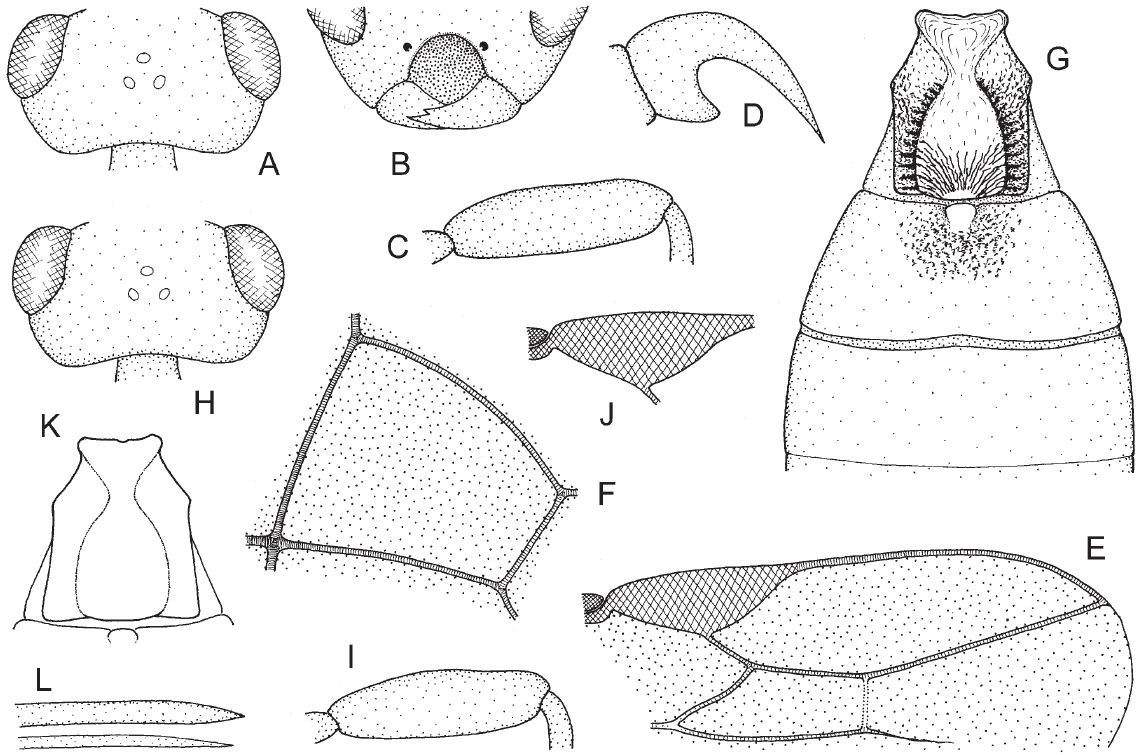
Fig. 36. Bracon ( Glabrobracon ) peroculatus Wesmael, 1838 (A-G: ♀ holotype, H-L: ♀). A . Head in dorsal view. B . Head in frontal view. C . Hind femur. D . Claw. E . Distal part of right forewing. F . First discal cell of right forewing. G . Tergites 1-3. H . Head in dorsal view. I . Hind femur. J . Pterostigma of right forewing. K . First tergite. L . Hind end of oviposior